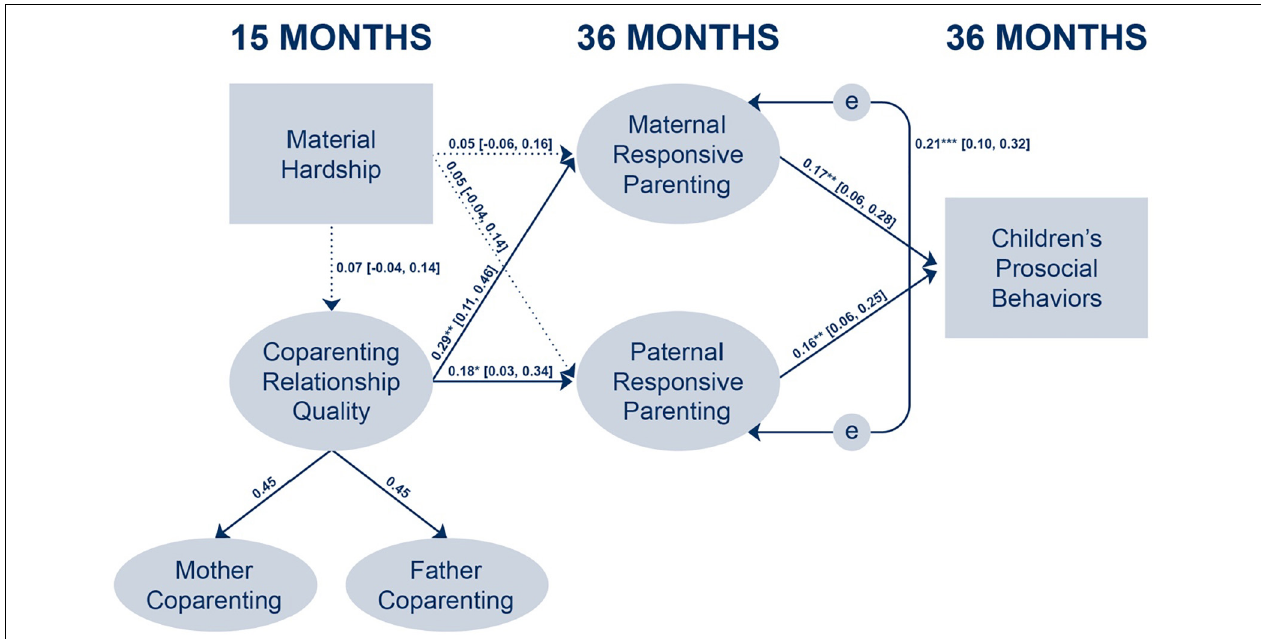
FIGURE 2 | Results of the final structural equation model. X 2 (928) = 1374.60, p < 0.001, RMSEA = 0.03, 90% CI (0.03, 0.04), CFI = 0.93, SRMR = 0.05. The model included the following sociodemographic control variables: White, Latinx, other, only one parent has a high school diploma, both parents have a high school diploma, fathers’ employment status, mothers’ depressive symptoms, fathers’ depressive symptoms, fathers’ multiple partner fertility, fathers’ involvement in caregiving, BSF random assignment status, and BSF program site location. Maternal depressive symptoms ( β = 0.13, p = 0.006) and paternal depressive symptoms ( β = 0.17, p = 0.003) were significantly associated with higher levels of families’ material hardship. Being Latinx ( β = –0.35, p = 0.001), maternal depressive symptoms ( β = –0.34, p < 0.001), and paternal depressive symptoms ( β = –0.30, p < 0.001) were significantly associated with lower levels of coparenting alliance. Being randomly assigned to the BSF intervention group ( β = 0.24, p = 0.001) was associated with higher levels of coparenting alliance. Standardized regression coefficients and 95% confidence intervals (in brackets) are shown. Dotted lines indicate non-significant paths. * p < 0.05, ** p < 0.01, *** p <